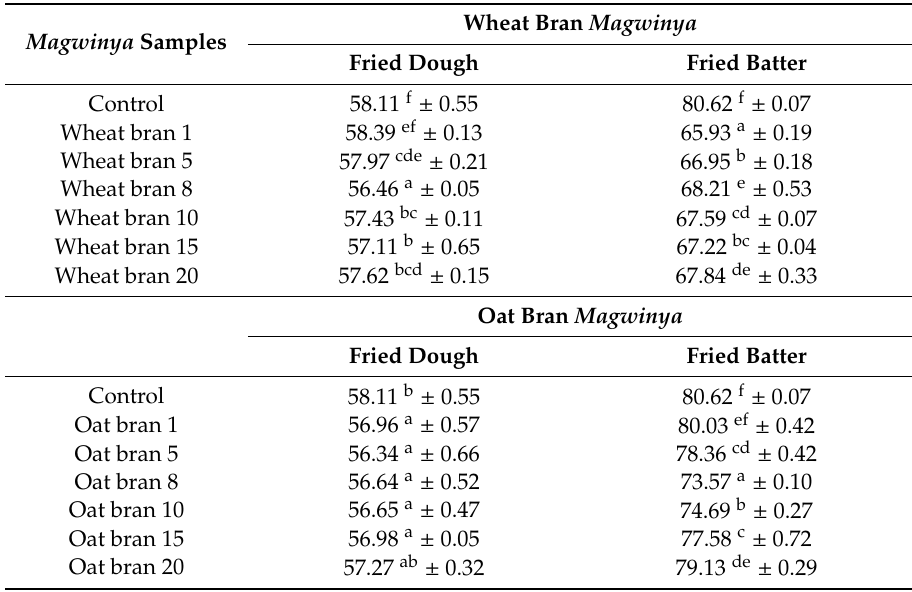
Table 2. The estimated glycaemic index of magwinya